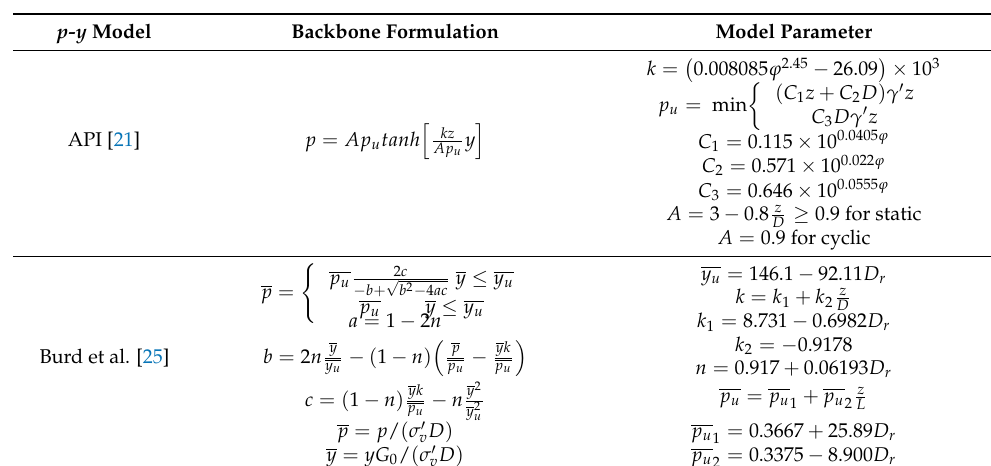
Table 1. The p-y models in API [21] and Burd et al.